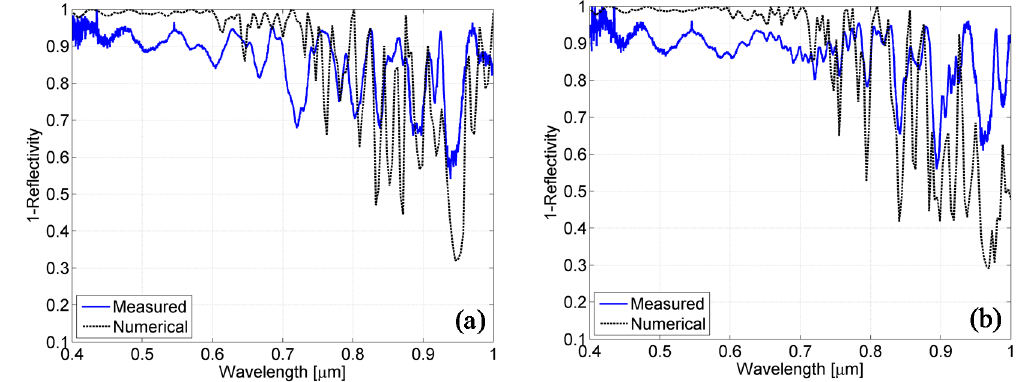
Figure 11. Comparison between the spectra obtained from the simulation of the second model (dotted black line) and those measured on the cells (solid blue line) for the cell growth on the textured superstrate with a nominal thickness of silicon of 800 nm ( a ) and for that of 1500 nm ( b